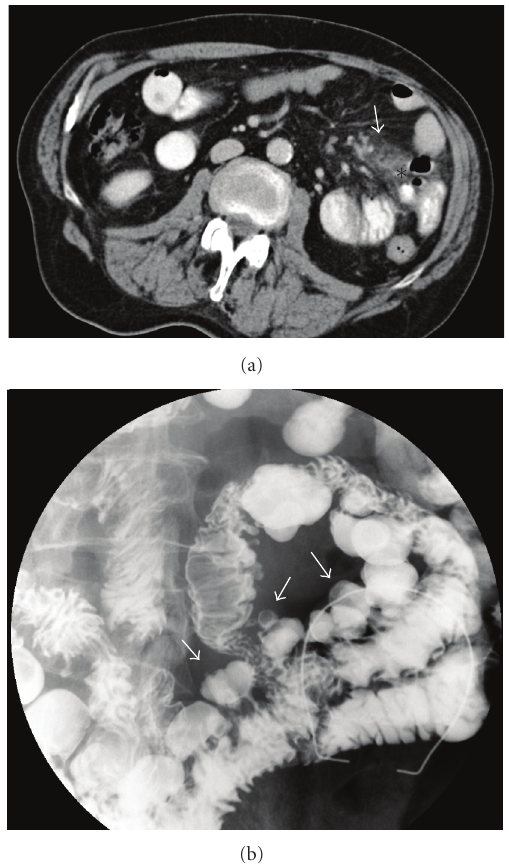
Figure 2: Transverse CT section through the lower abdomen reveals localised inflammatory changes in the left mesenteric root (arrow). Centrally within this pseudomass, several air containing small- bowel diverticula can be noted (arrow heads).